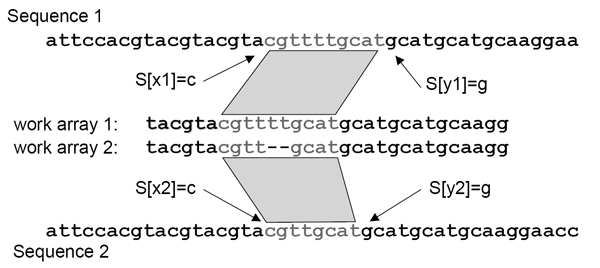
The principle of window alignment. Definition of the variables x1, y1 and x2, y2 used for match extension with gaps. Sequence 1 and Sequence 2 are matching parts of the concatenated long sequences S that is stored in memory. The sliding window of length 10 is marked by grey colour.